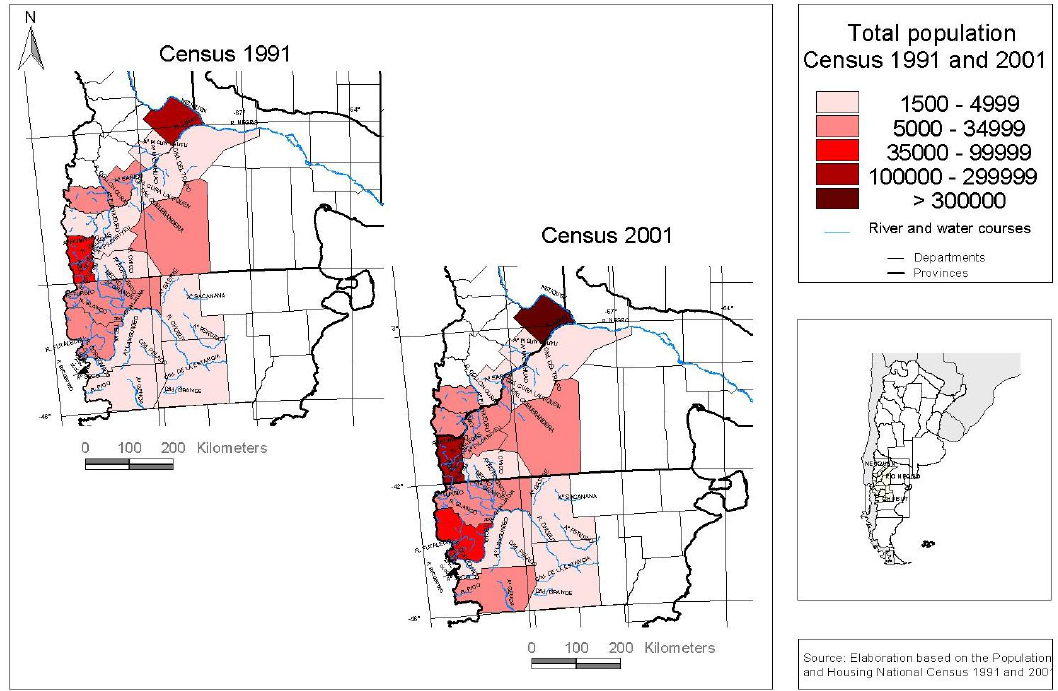
Figure 3. Population Census in 1991 and 2001 in the studied region. The river network is superimposed on the map, adapted from